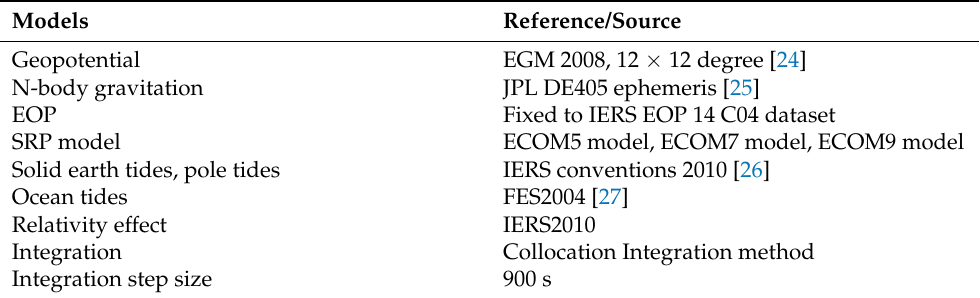
Table 1. Dynamical models and integration